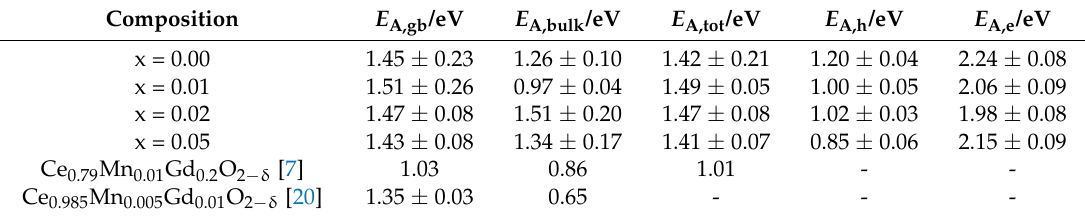
Table 2. Activation energies for bulk, grain boundary and total transport from impedance